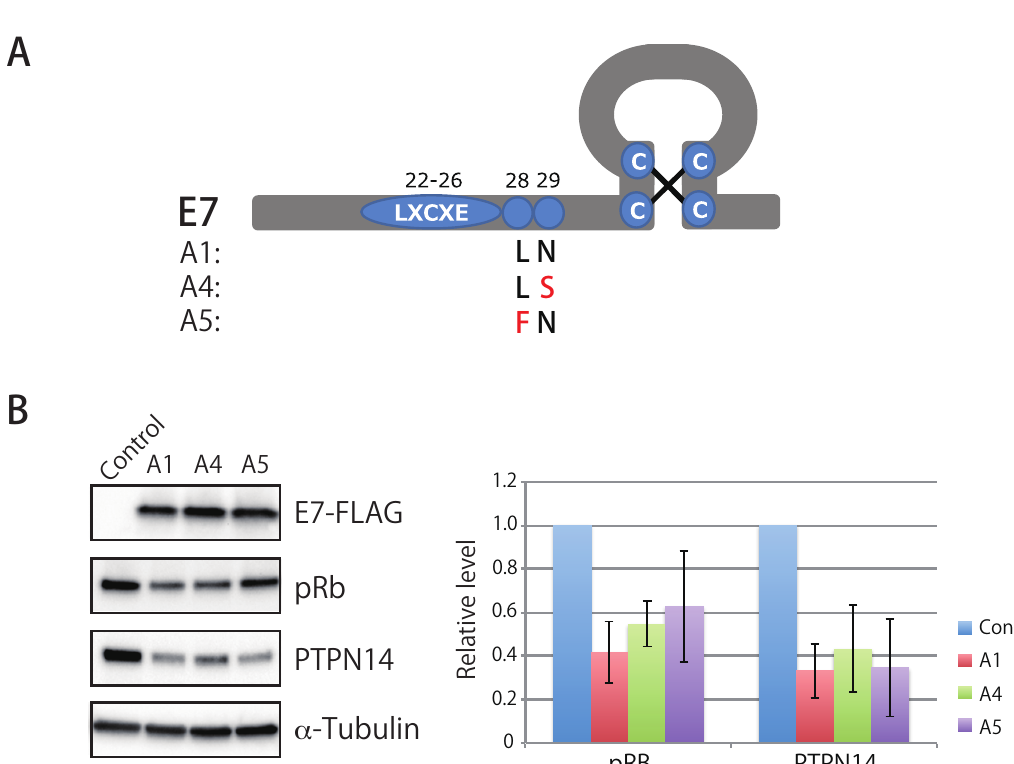
Figure 4. Biological activity of the E7 proteins of HPV16 lineage A variants. ( A ) Schematic representation of the HPV16 E7 protein. The LXCXE motif required for degradation of the retinoblastoma protein (pRb) and amino acid residues characteristic for A1, A4, and A5 are shown. ( B ) Western blot analyses of cell extracts from E7-transduced human cervical keratinocytes. Representative results of three independent experiments are shown in the left panel. Expression levels of pRb and PTPN14 were quantified as the relative band intensity of each protein adjusted with that of α -tubulin, and the average and standard deviation of the three experiments are shown in the right panel. No significant di ff erence was observed for pRb levels between A1 and A5 ( p = 0.23, paired t